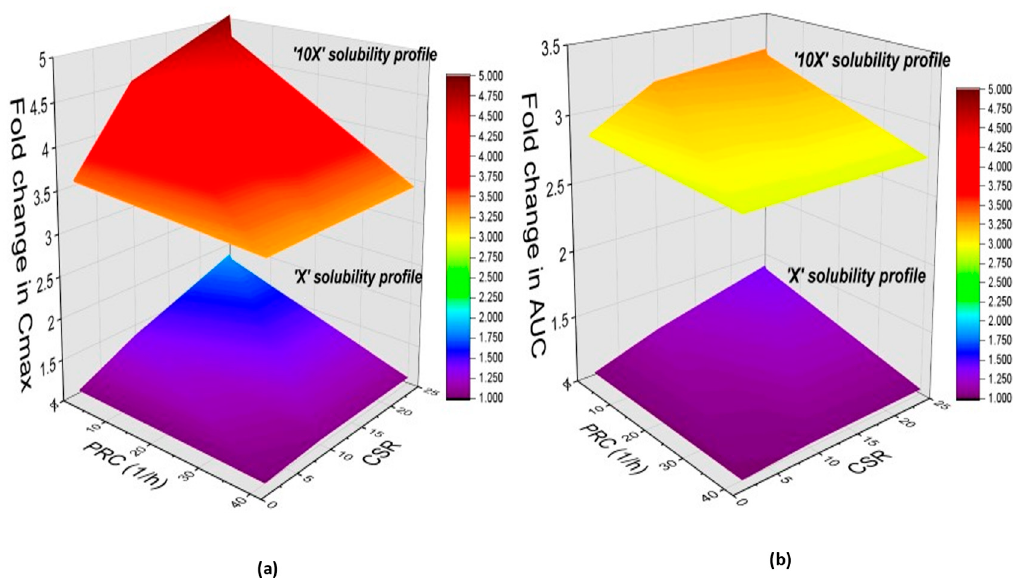
Figure 6. Simulated in fl uence represented by the fold change of degree of supersaturation and precipitation rate on pharmacokinetic parameters: ( a ) Cmax and ( b ) AUC. Each figure represents the data of the (cid:31)X’ and (cid:31)10X’ solubility pro fi les.